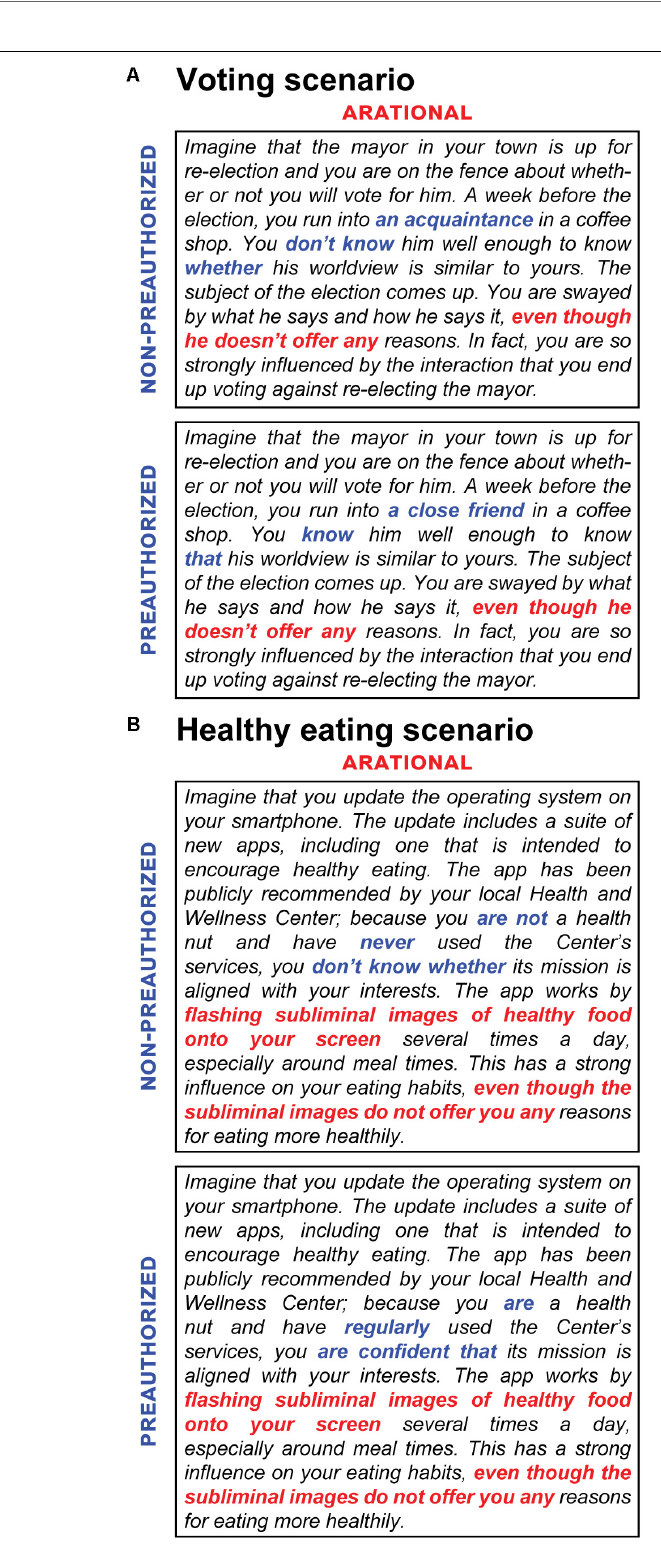
FIGURE 1 | Contrastive vignettes. (A) The four vignettes used in the voting scenario. All differences between the ARATIONAL (left) and RATIONAL (right) conditions are shown in red; all differences between the NON - PREAUTHORIZED (upper) and PREAUTHORIZED (lower) conditions are shown in blue. Since questions are identical for all respondents, any differences in responses between conditions must be due to the differences between vignettes (shown in red and blue). Black text is identical across all conditions. (B) As in (A) , for the healthy eating scenario.